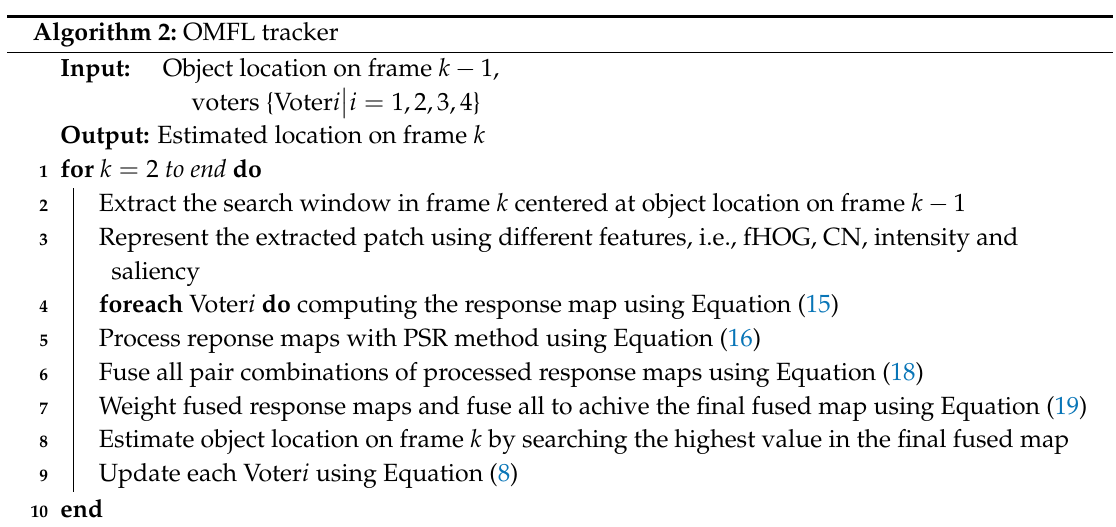
Algorithm 2: OMFL